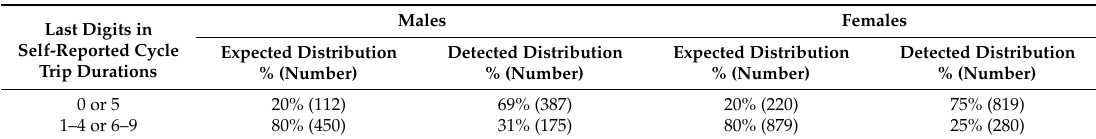
Figure 3. The frequency distribution of individual self-reported cycle commuting durations ( n = 1661). The duration values were divided into consecutively numbered clusters of last digit categories: